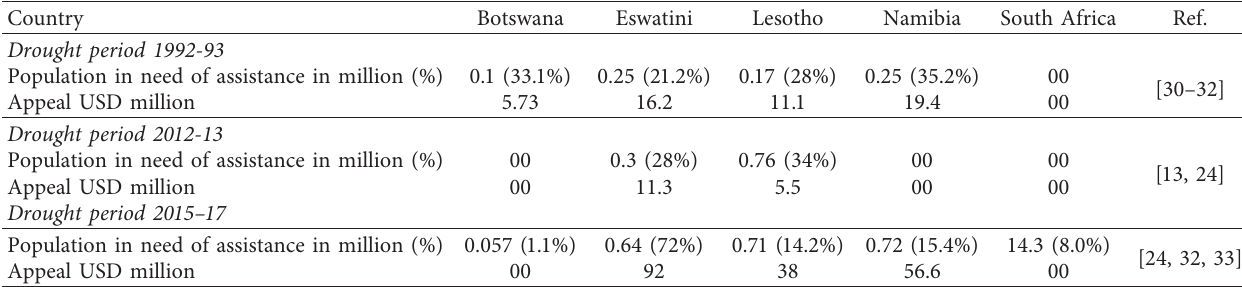
Table 1: Regional selected humanitarian appeals for drought emergency response.